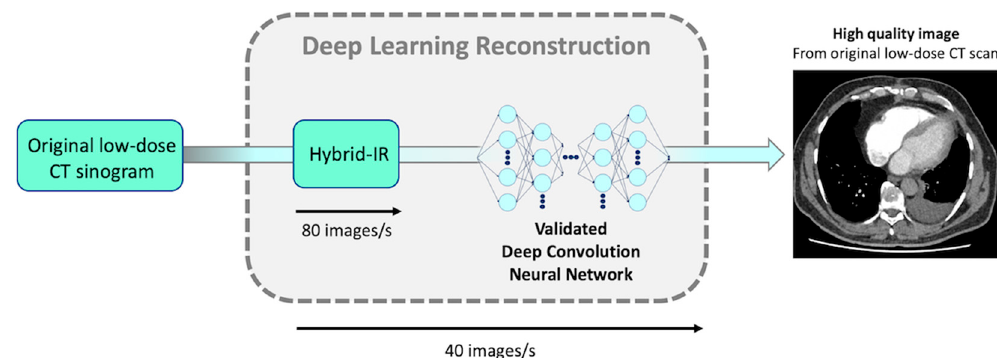
Figure 2. Schematic representation of DCNN direct application in clinical settings. DLR’s reconstruction time is up to 80 slices/s (similar to conventional hybrid-IR’s reconstruction time). DCNN, deep convolution neural network; DLR, deep learning reconstruction; CT, computed tomography; IR, iterative reconstruction.